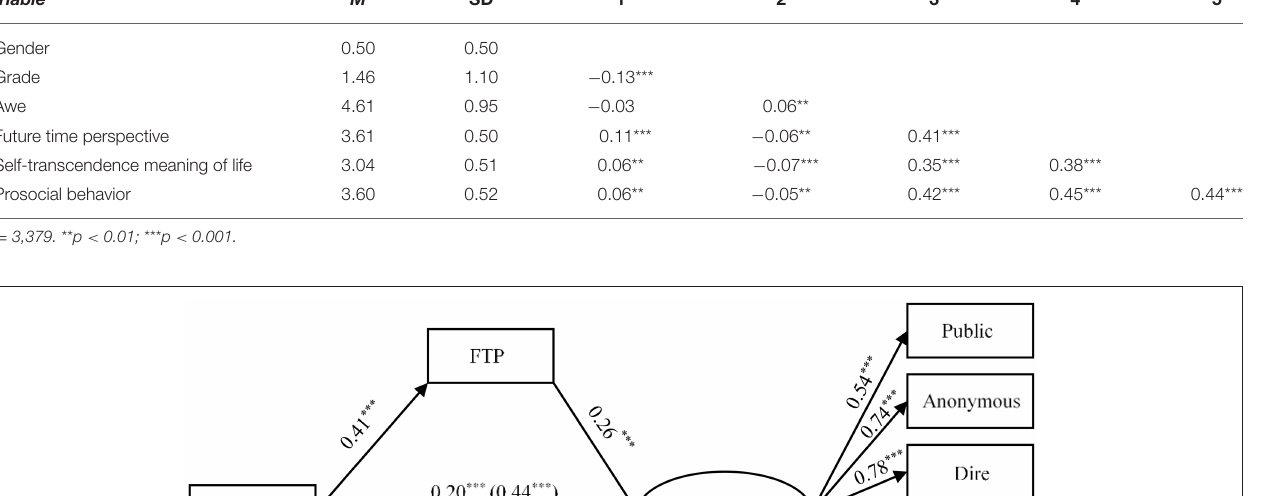
TABLE 1 | The means, standard deviations, correlations, and reliabilities among the variables. Variable